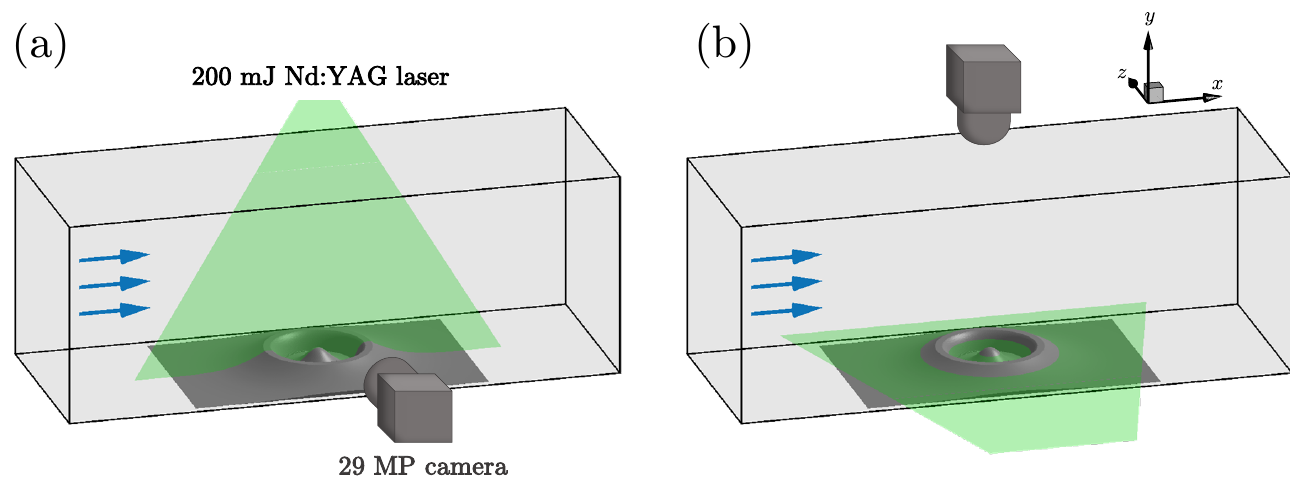
Figure 1. Perspective views of the imaging setup used for the ( a ) wall-normal and ( b ) wall-parallel PIV